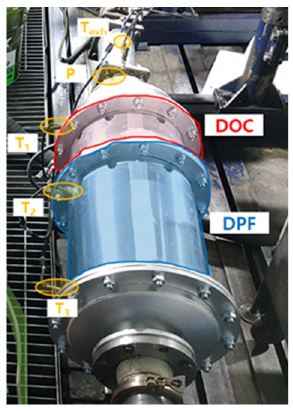
Figure 2. Target system: DOC and DPF. Table 1. Specification of diesel particulate filter.